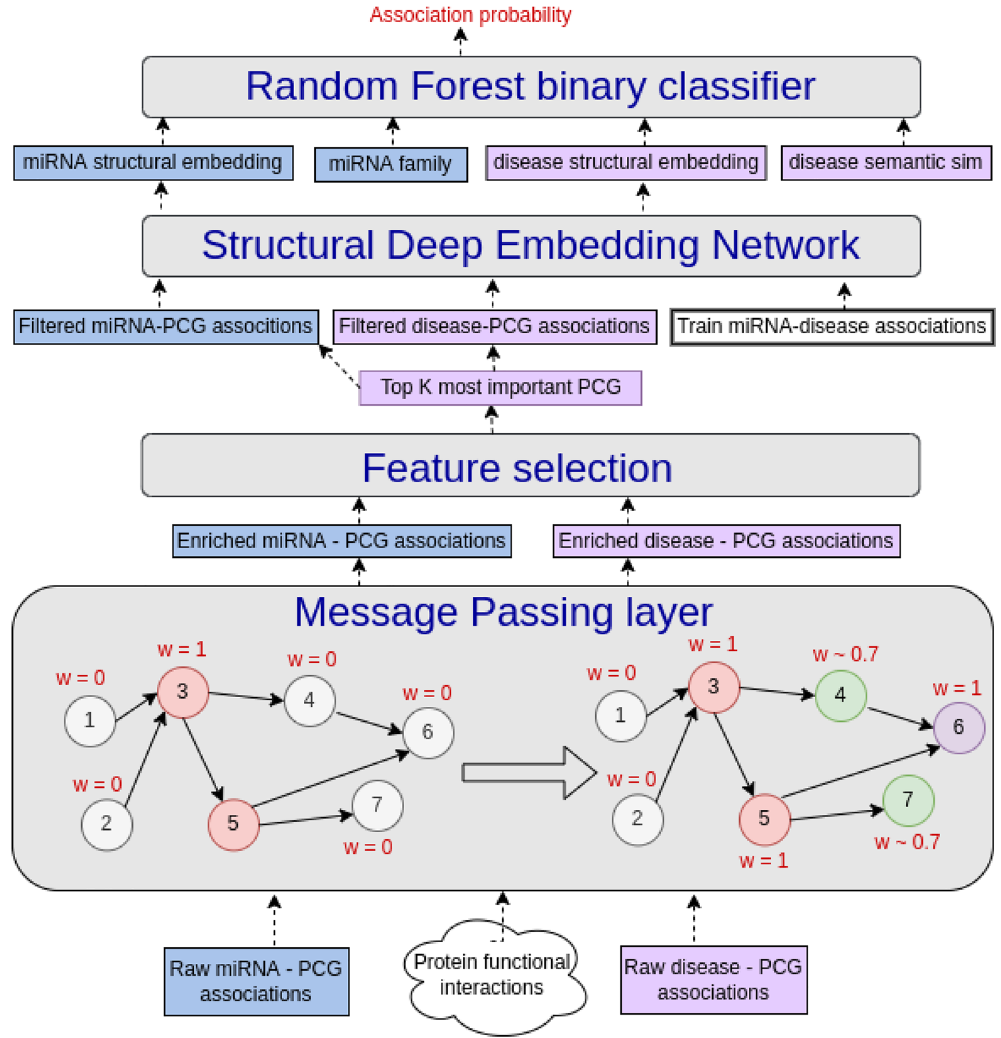
Figure 3. MPM’s architecture. MPM consists of a message passing layer (section “The message passing framework/module”) , a feature selection with a side supervised task (section “The feature selection module”), a Structural Deep Embedding network (section “The structural embedding learning”), and a binary classifier (section “The classification module”).